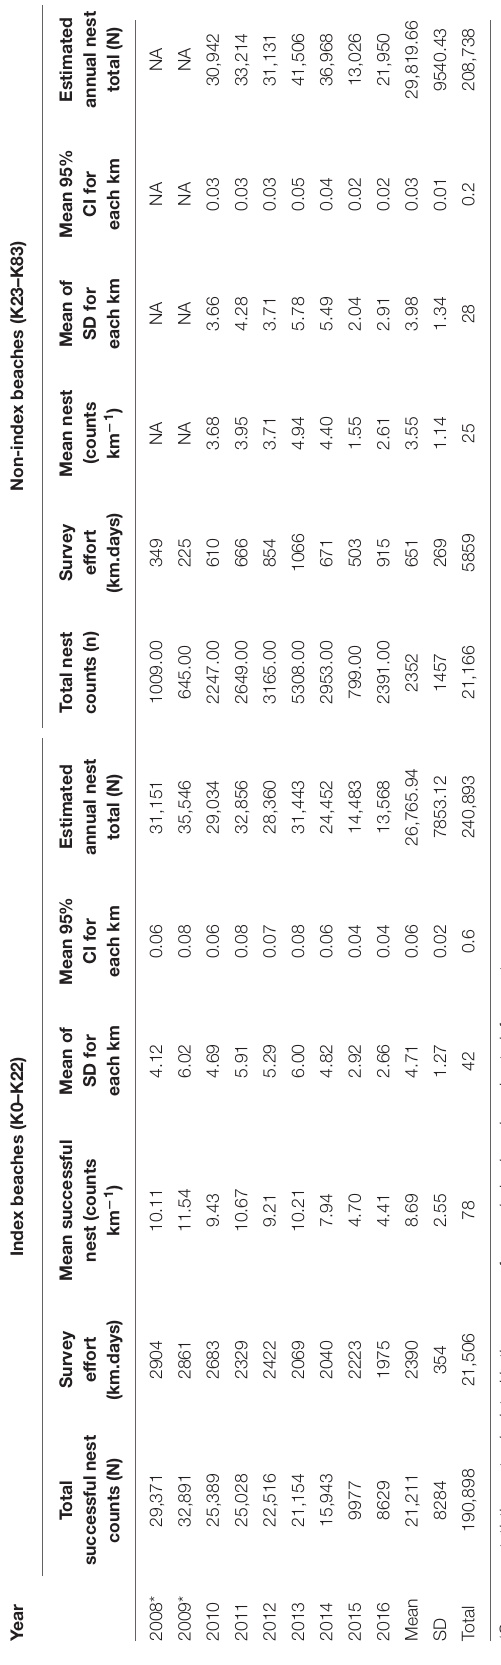
of nest counts for index beaches in comparison to non-index beaches across all years; for index beaches the standard deviation is 54% of the mean nesting density of 8.69 nests day − 1 km − 1 (mean of SD within all years = 4.71), whereas for non-index beaches the standard deviation is 98% of the mean nesting density of 3.55 nests km − 1 day − 1 (mean of SD within all years = 3.48). The percent of undetermined nesting attempts in relation to the total track count accounts for measurement